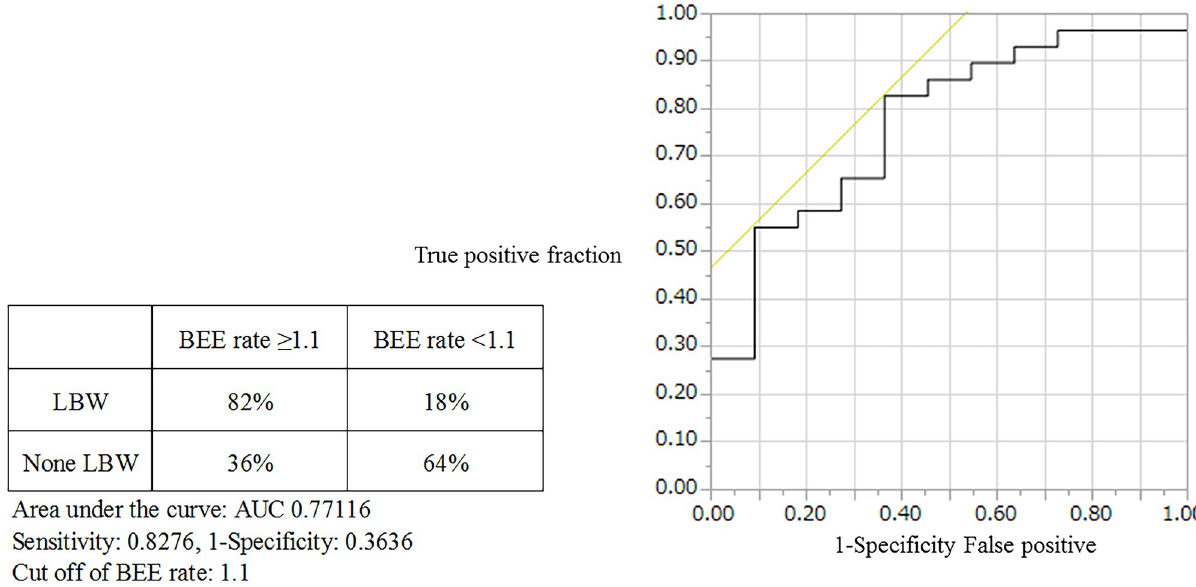
Fig 5. Receiver operating characteristic curve for weight loss and basal energy expenditure sufficiency rate from T1 to T2.